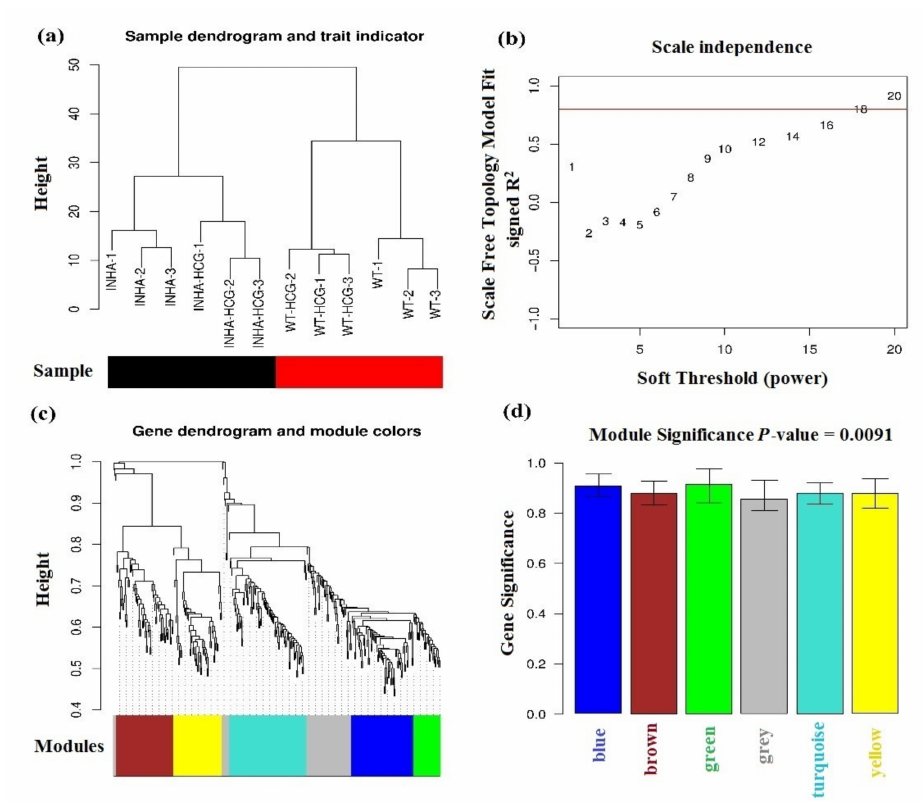
Figure 4. ( a ) Sample clustering tree. The Black and red bars mean different types of samples. ( b ) power-law coefficient parameter plot X-axis means soft-threshold, Y-axis means scale-free topology model fit signed R-square. ( c ) Modules clustering tree, different colors in the bottom mean different modules. ( d ) Module bar plot, X-axis means different modules, Y-axis means the significance of genes in each color module based on their different physiological phenotypes.